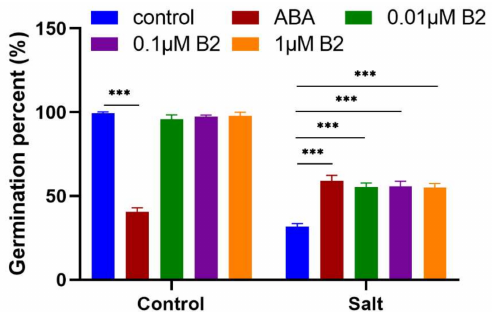
Figure 1. The germination percentage of maize treated with different concentration of B2 was improved under the salt stress. ABA concentration was 100 Mm. Values were significantly different from controls by t -test at *** p ≤ 0.001. Bars mean SD ( n =